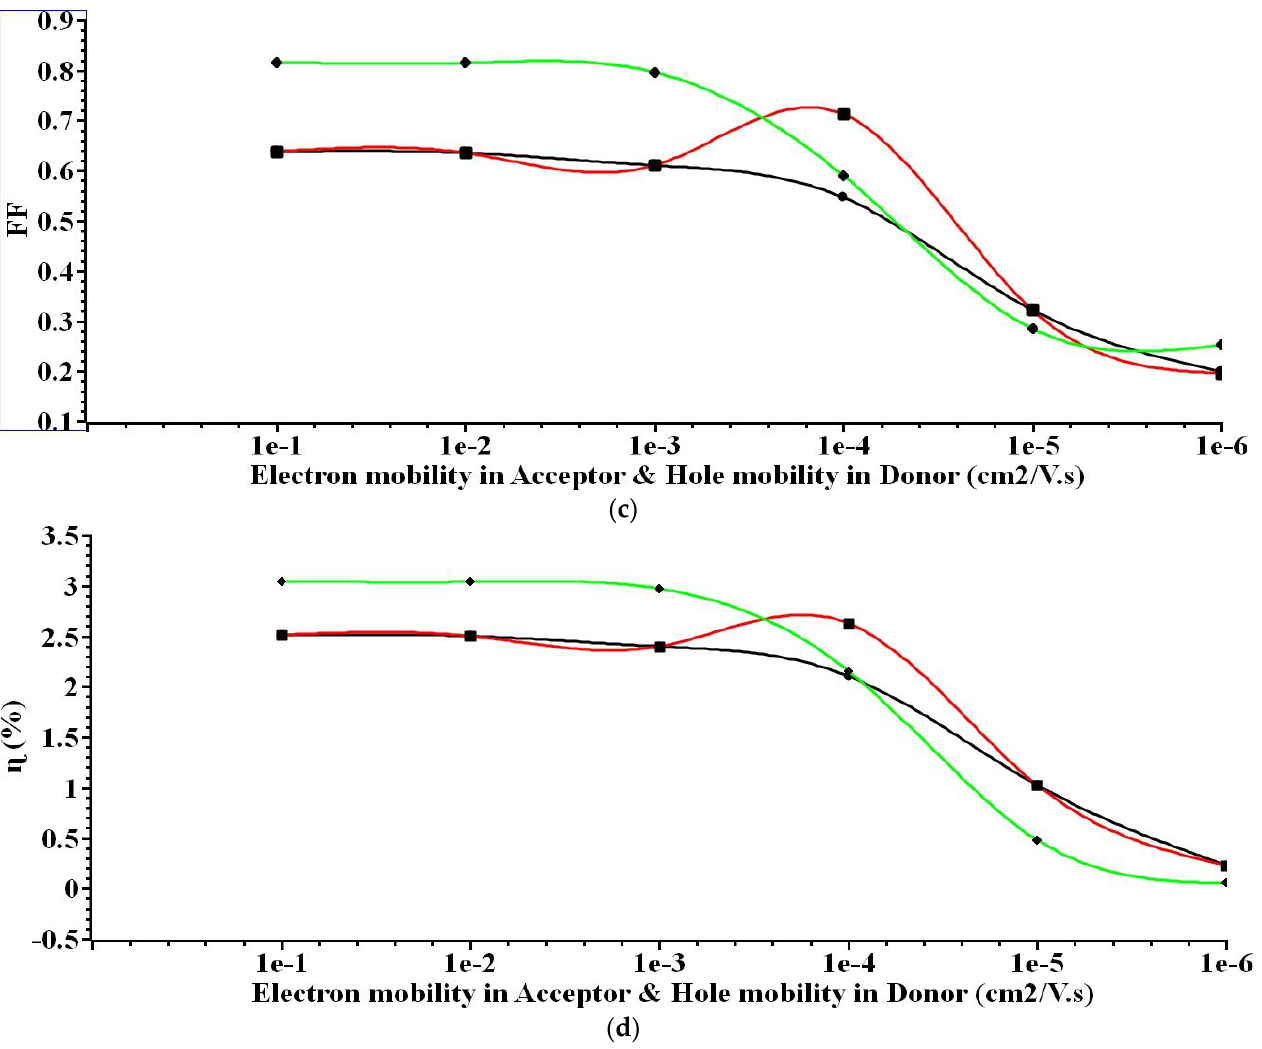
Figure 5. ( a ) J sc ( b ) V oc ( c ) FF ( d ) ɳ . Illustrates the output extracted for various mobility charge carriers.